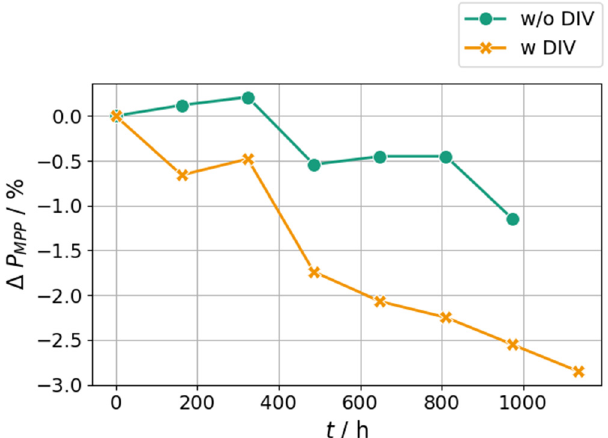
Fig. 10. Relative changes of P MPP at STC of two modules during dark storage at 75 ° C with (M13) and without DIV monitoring